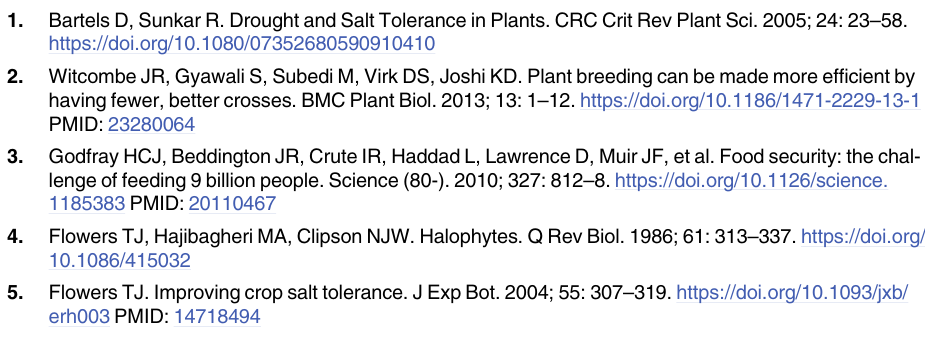
S2 Fig. Automatic Barcode Gap Discovery (ABGD) analysis of barcoding markers, (a) Histo- gram of distances, (b) graph of ranked distances, (c) Automatic partition. S1 Table. DNA barcode primers sequences used in this